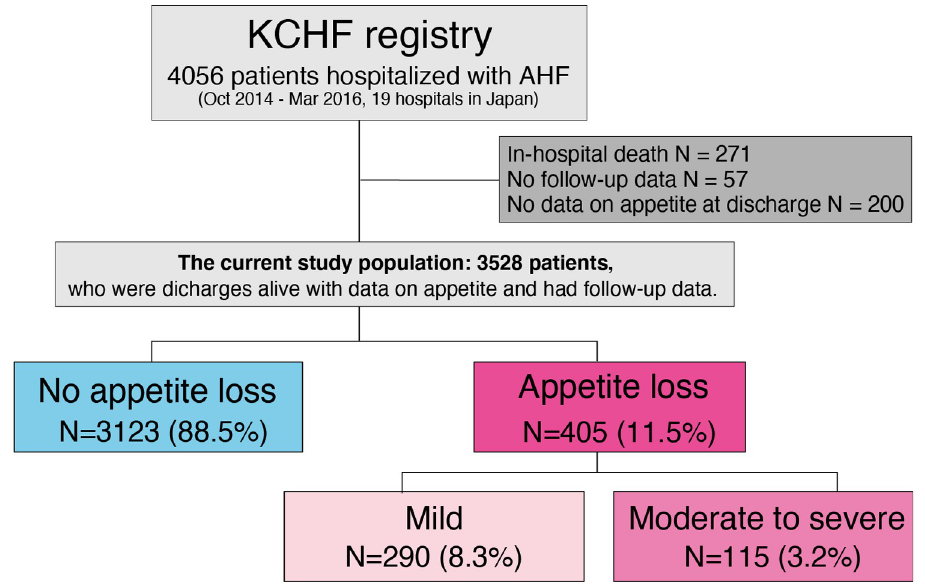
Fig 1. Study flowchart. ADHF = acute decompensated heart failure, KCHF = Kyoto Congestive Heart Failure.